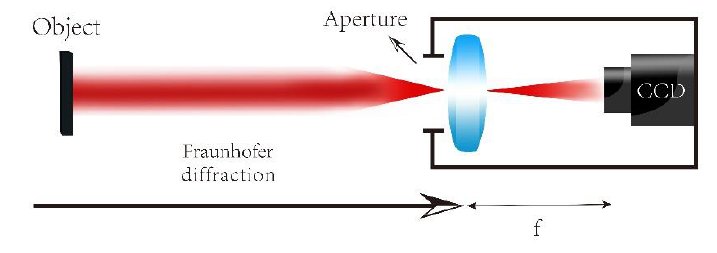
Figure 2. Path of the 4f system simplified by far-field diffraction.